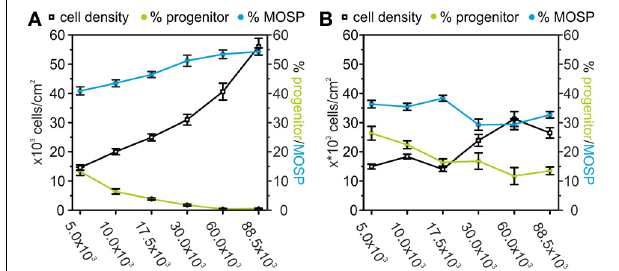
FIGURE 9 | Effects of TNF- α and IFN- γ treatment on A2B5-positive progenitors and MOSP-positive oligodendrocytes after 9 days in serum-free culture. (A) Dependence of the number of surviving cells (counted from DAPI-positive nuclei—black), progenitor cells (green), and MOSP-positive oligodendrocytes (blue) after 3 days of incubation in proliferation medium and 6 days in differentiation medium based on RPMI. Note the decrease in the percentage of bipolar progenitor cells and increase of MOSP-positive cells with increased cell density at time of seeding. (B) Dependence of the number of surviving cells (counted from DAPI-positive nuclei—black), bipolar progenitor cells (green), and MOSP-positive oligodendrocytes (blue) under identical conditions as used for data shown in (A) with the exception of adding 10ng/ml TNF- α and 20ng/ml IFN- γ from d2–d3. Note the increase in the percentage of progenitor cells and the decrease in the percentage of MOSP-positive cells at all cell densities studied. Error bars indicate ±